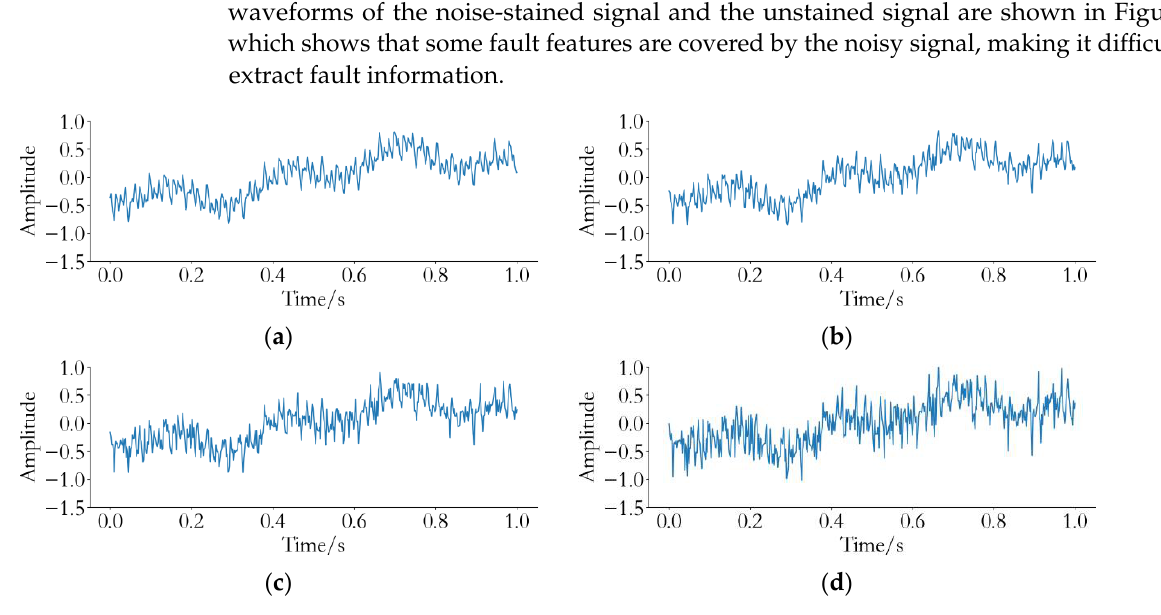
( c ) Figure 4. Entropy distribution of IMFWPE, IMFPE, and IMPE for different signal-to-noise ratio signals: ( a ) IMPE entropy distribution; ( b ) IMFPE entropy distribution; ( c ) IMFWPE entropy dis- tribution. Table 1. Entropy correlation coefficient of vibration signal before and after noise addition. Correlation Coefficient